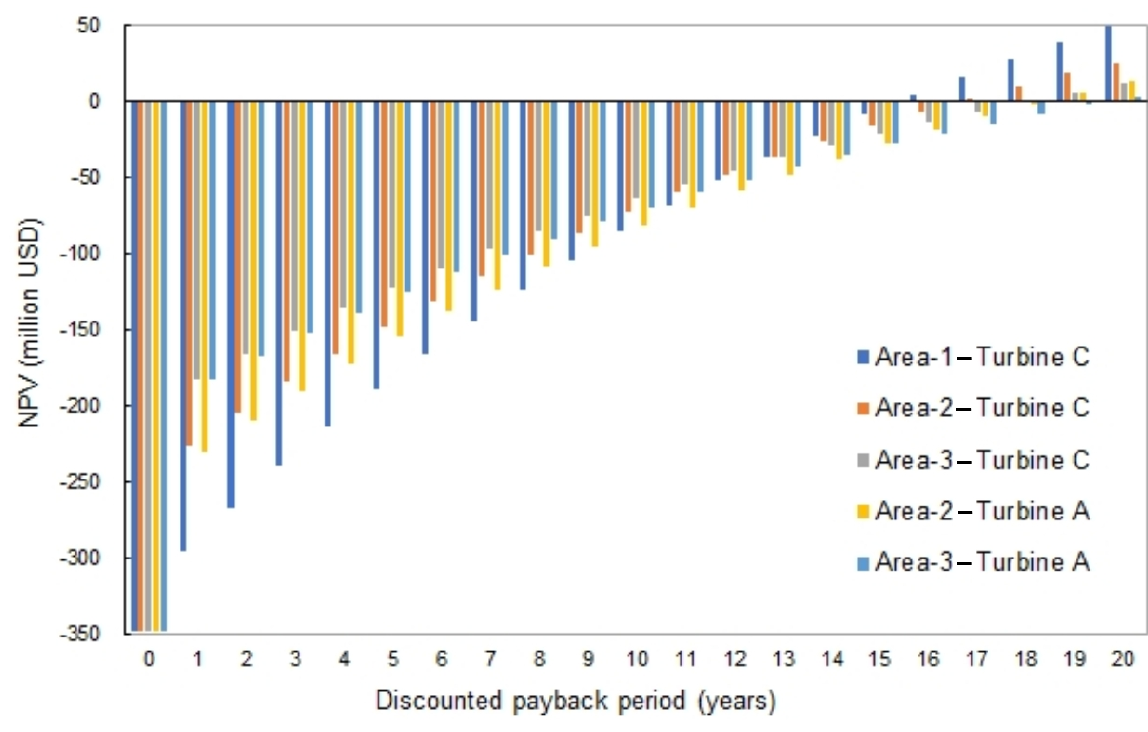
Figure 15. Discounted payback period for five feasible scenarios for wind farms off Wetar Island.